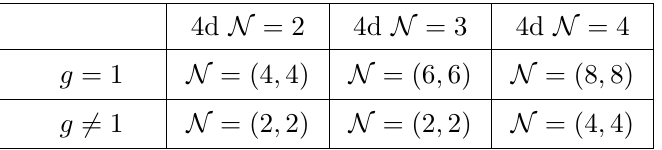
Table 2 . 2d supersymmetry preserved by topological reduction on F g